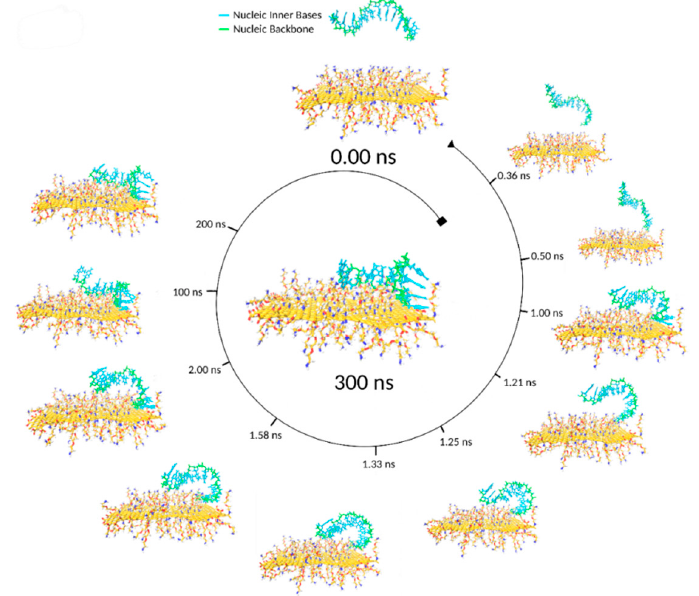
Figure 9. Trajectory snapshots ranging from 0 to 300 ns of ssDNA and rGO-PEG-NH 2 in the presence of both Mg 2+ and Cl − atoms (ions not shown).